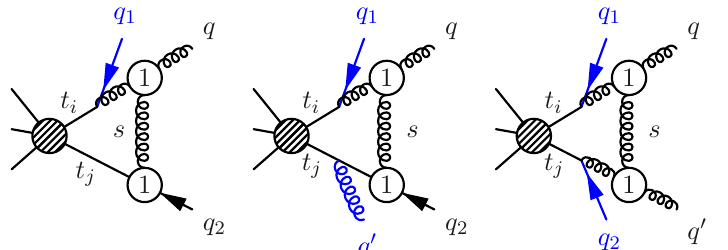
(cid:16) (cid:17) (cid:0) (cid:1) J T 1 J T 1 (cid:31); YM (cid:31);(cid:24) i j ! J B 1 J B 1 (right). i j